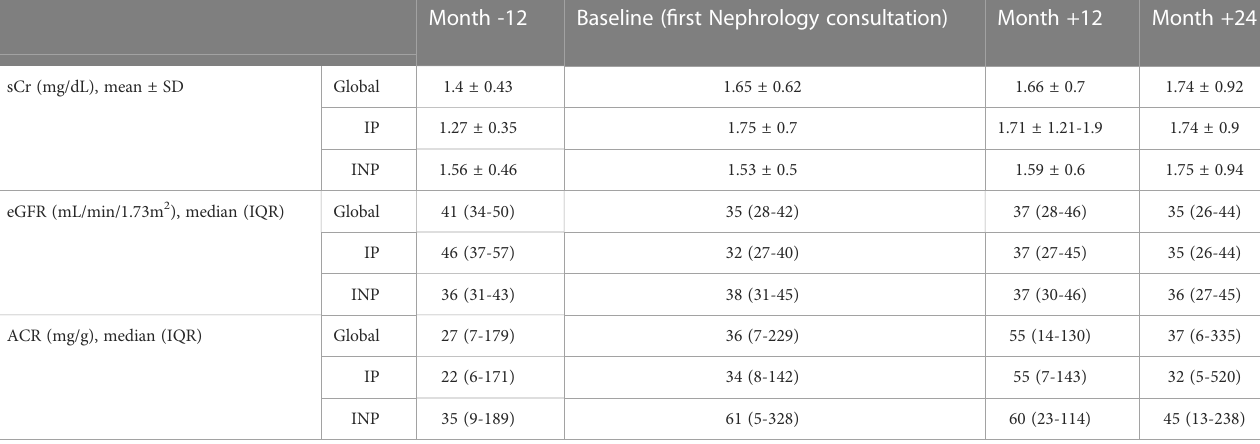
TABLE 3 Evolution of renal function in all